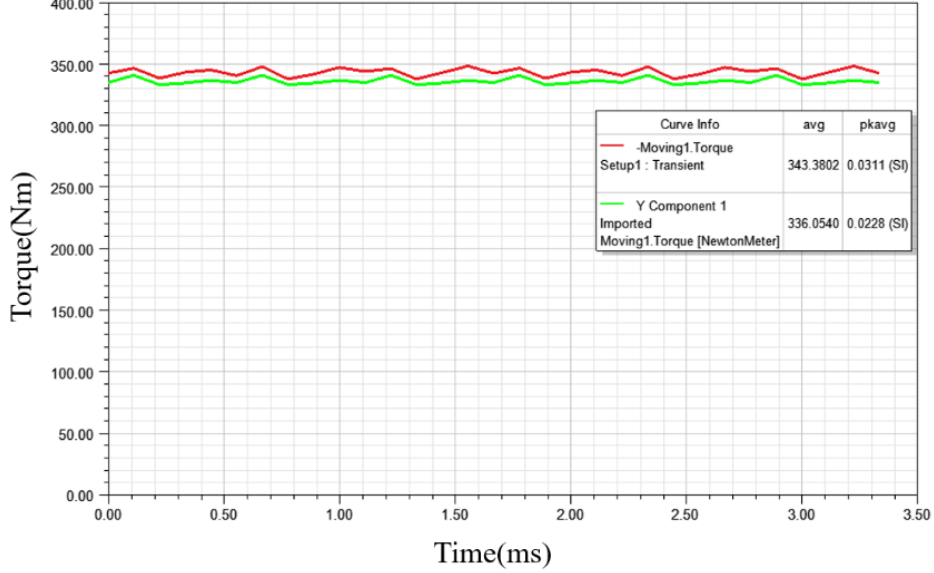
Figure 13. Torque comparison of non-grain-oriented silicon steel electrical machine (green line) and grain-oriented silicon steel electrical machine (red line).